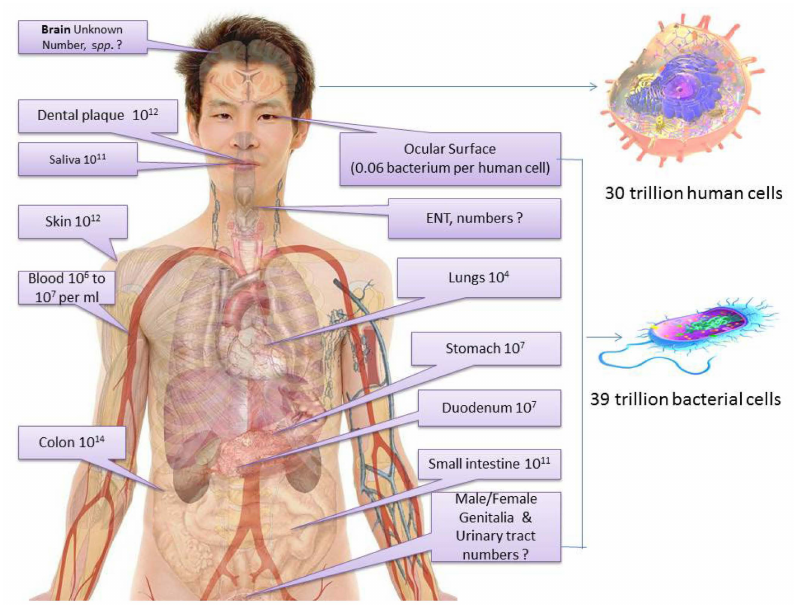
Figure 1. Organ-specific symbiotic bacterial cells in the human